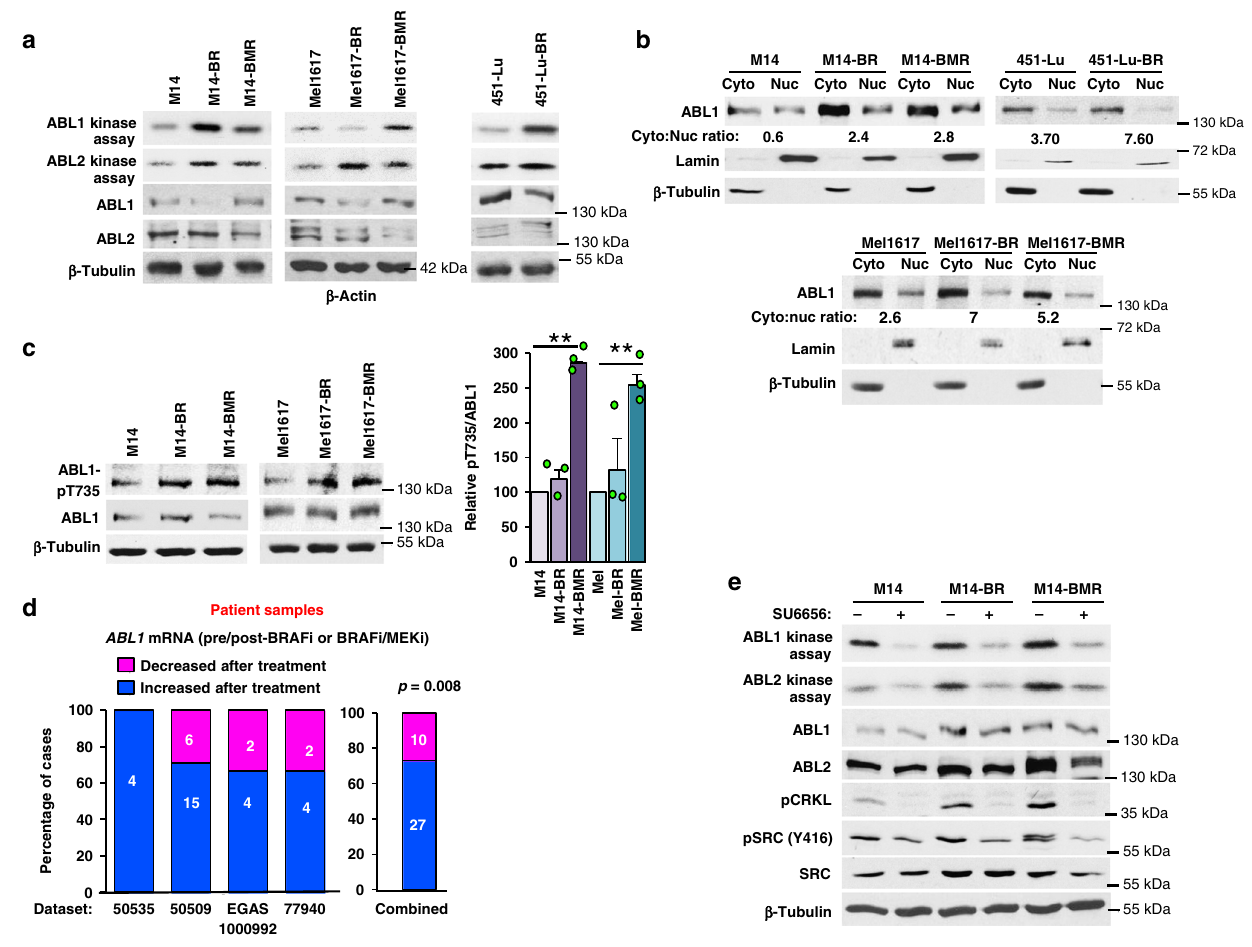
Fig. 1 ABL kinase activities are potentiated following resistance to BRAF and BRAF/MEK inhibitors. a Parental (M14, Mel1617, 451-Lu), BRAFi (-BR), or BRAFi/MEKi-resistant (-BMR) cell lines were serum-starved and subjected to in vitro kinase assay (top two panels) or western blot (rest of the panels) for total protein expression. For kinase assays, ABL1 was immunoprecipitated with K12 antibody, whereas ABL2 was immunoprecipitated with ABL2-speci fi c antibody 19,62 , and IPs incubated with substrate (GST-CRK) and radiolabeled (gamma- 32 P)-ATP (see “ Methods ” ). Kinase quantitation for n = 3 – 5 biological replicates is shown in Supplementary Fig. 1d. b Resistant cell lines ( a ) were fractionated into nuclear (nuc) and cytoplasmic (cyto) fractions, equal percentages of cytoplasmic/nuclear fractions loaded for each line, and fractions blotted with the indicated antibodies. Lamin and tubulin blots were used to demonstrate the purity of nuclear and cytoplasmic fractions, respectively. ABL1 cytoplasmic:nuclear ratio is noted for each cell line, and quantitation for all lines is shown in Supplementary Fig. 1e. A representative of n = 2 independent experiments is shown. c Lysates from a were blotted with the indicated antibodies and quanti fi ed. Graph shown is mean ± SEM for three independent experiments. ** p = 0.006 using single sample t -tests (two-sided) and Holm ’ s adjustment for multiple comparisons. d Primary human paired melanoma datasets (RNAseq-77940, 50535, 65185, EGAS00001000992; microarray- 50509) were analyzed for ABL1 mRNA levels pre-/post-BRAFi, MEKi, or BRAFi/MEKi treatment. Numbers in each column indicate number of cases. All cases were included; repeated analyses using particular cut-off values are shown in Supplementary Fig. 1f). p = 0.008 for the combined set using a two- sided binomial (right). e Parental and resistant cells were serum-starved, treated with vehicle (DMSO) or SFK inhibitor, SU6656 (10 μ M), for 16 h and lysates were subjected to in vitro kinase assay (top two panels) and western blot (all other panels) as in a